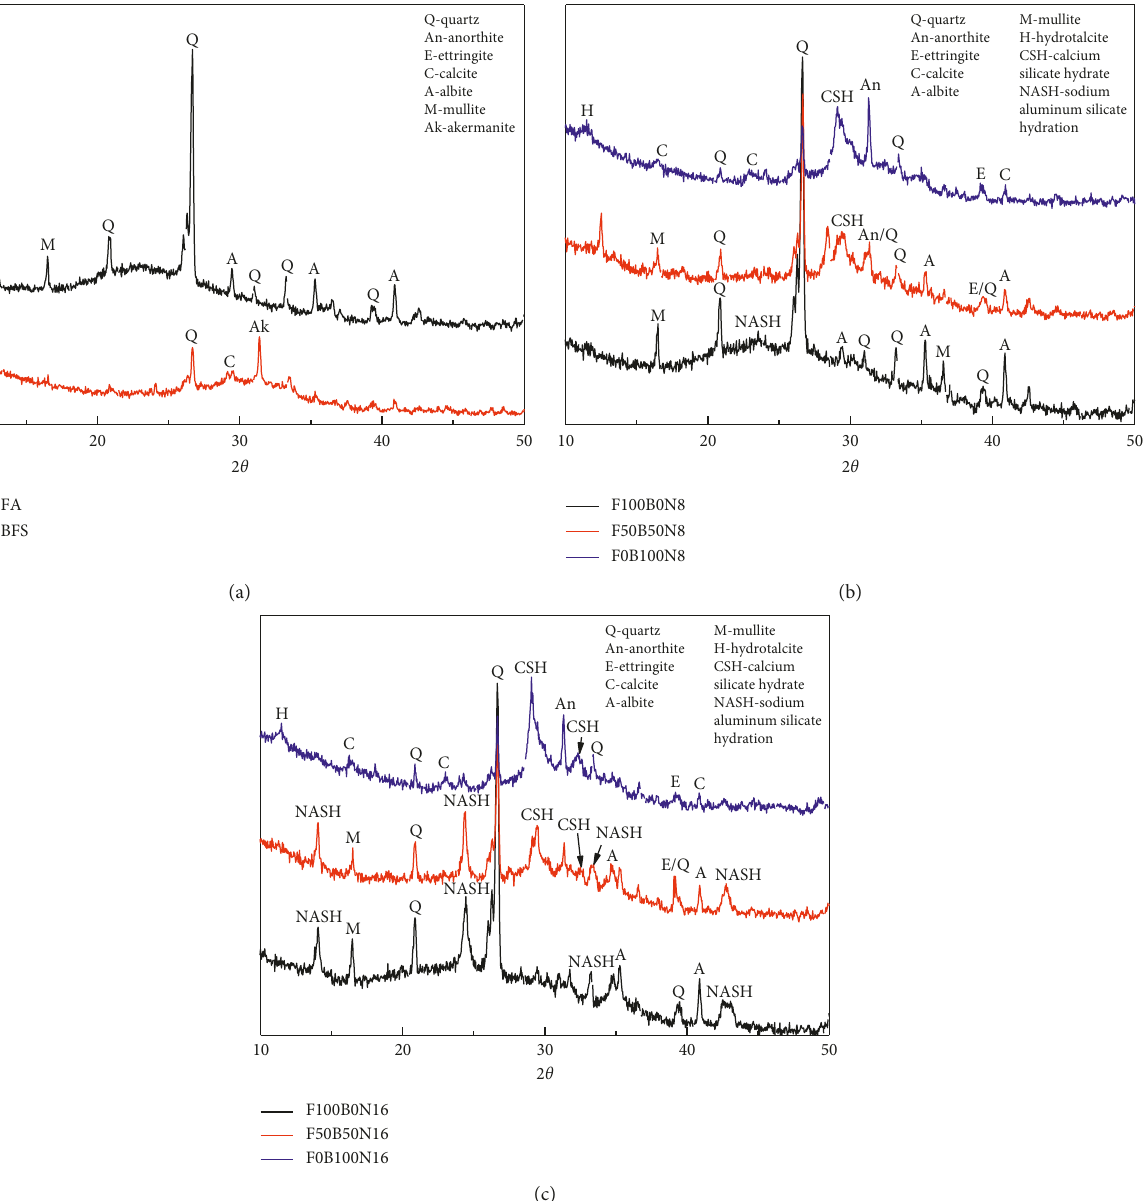
Figure 2: XRD patterns of (a) FA and BFS and geopolymer pastes with (b) 8M NaOH solution and (c) 16 M NaOH